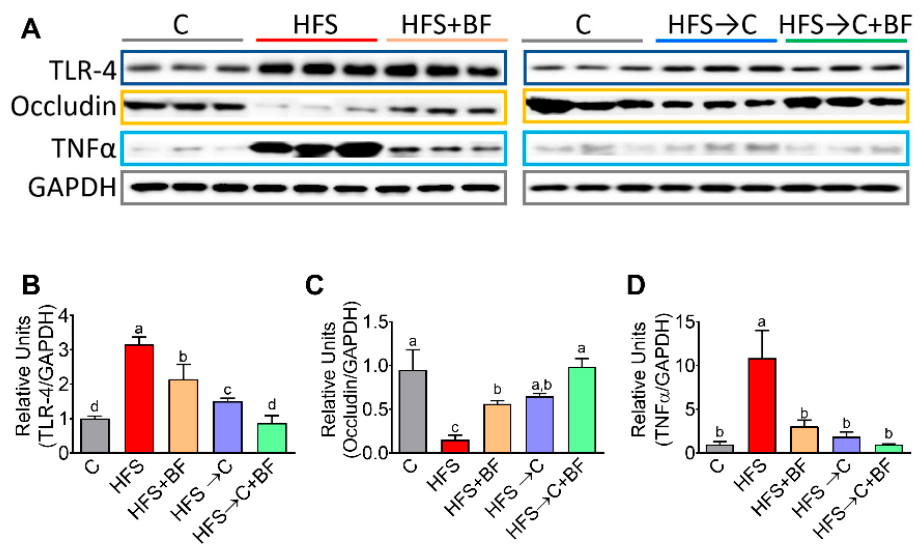
Figure 4. Gut barrier is improved with bioactive foods consumption. ( A ) Western blot analysis and ( B – D ) densitometric analysis of intestinal TLR-4, occludin and TNF α of rats fed control ( C ) or high fat diet + 5% sucrose (HFS) with or without bioactive foods. Data are expressed as the mean ± SD. Mean values with different letters show statistical differences between each other (a > b > c > d). Data were analyzed by one-way ANOVA followed by Tukey post-hoc test. Results were considered statistically significant at p < 0.05.